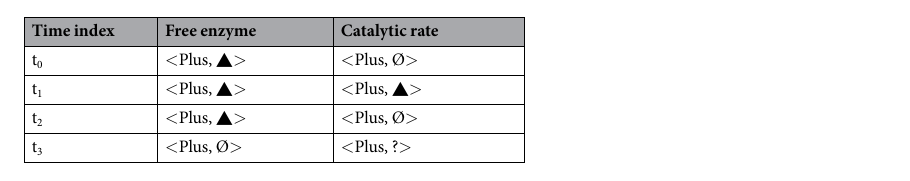
Table 4. Limited hydrolysis restart due to extra processes (TB2 ′